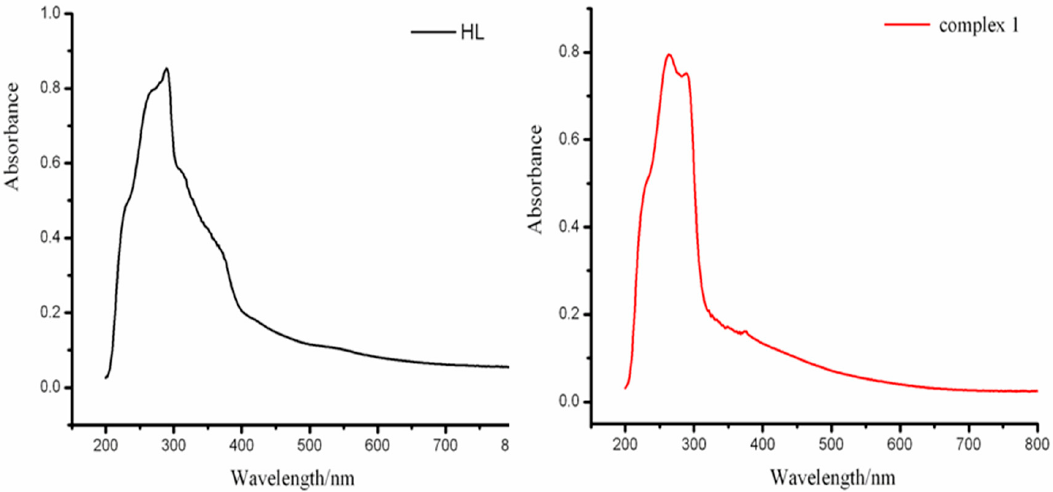
Figure 5. The UV-Vis spectra in the solid-state of HL and 1 .